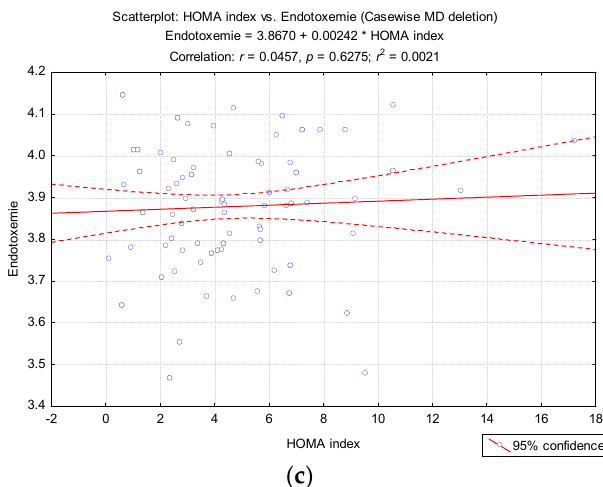
Scatterplot: HOMA index vs. Endotoxemie (Casewise MD deletion)